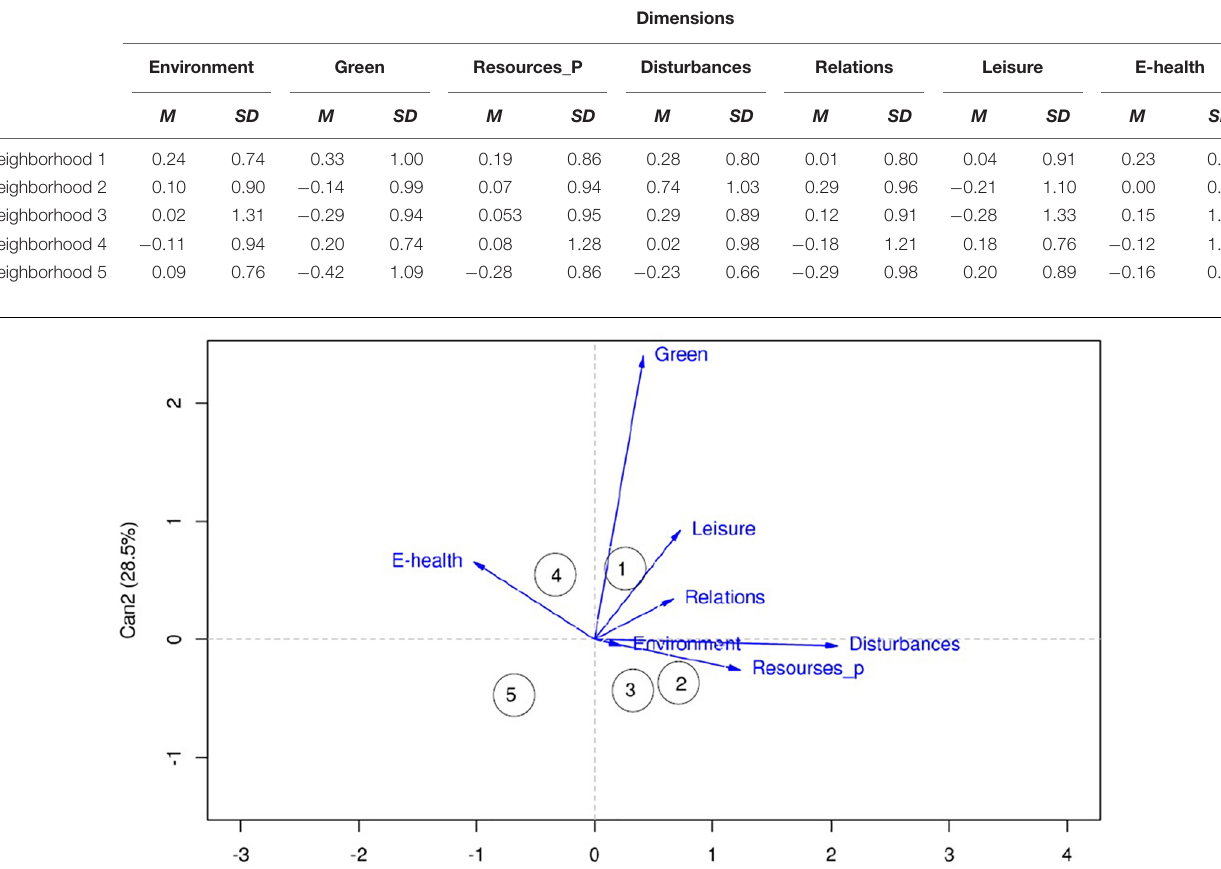
TABLE 1 | Mean scores and typical deviations of the factorial scores by neighborhood in each factor.